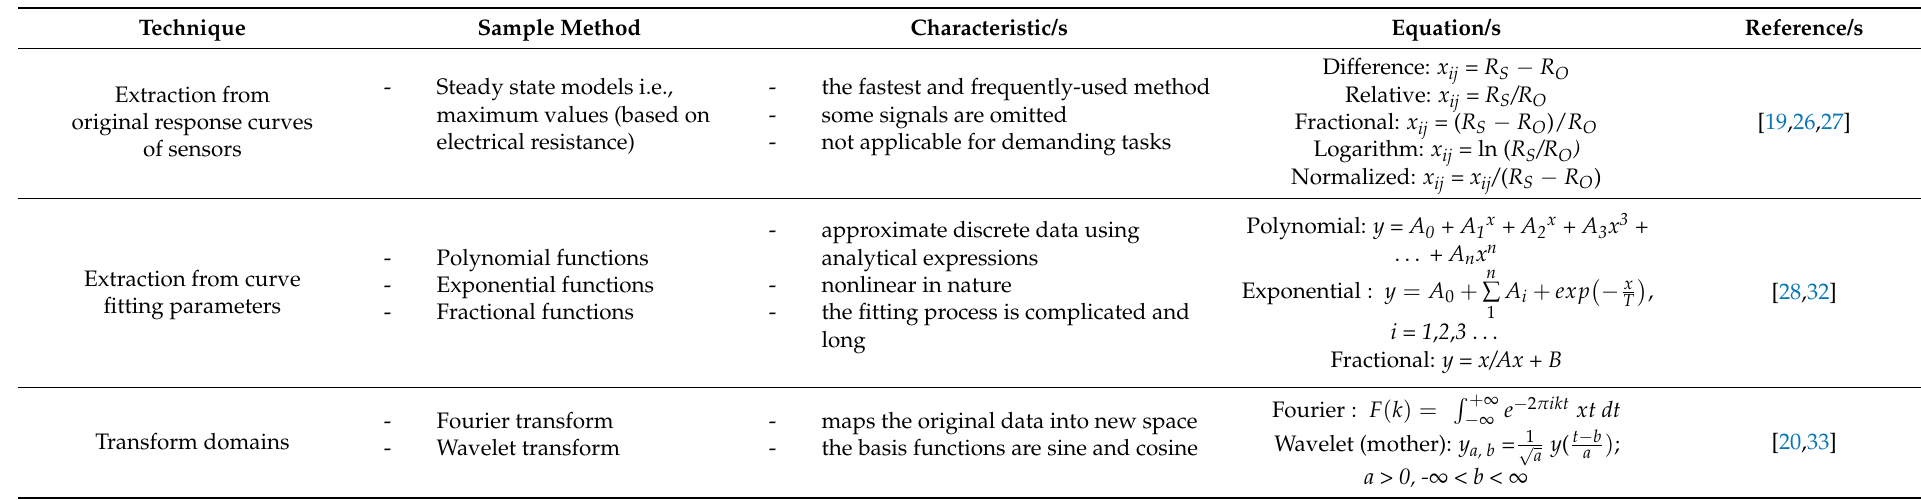
Table 1. Overview of the principal feature extraction methods and related